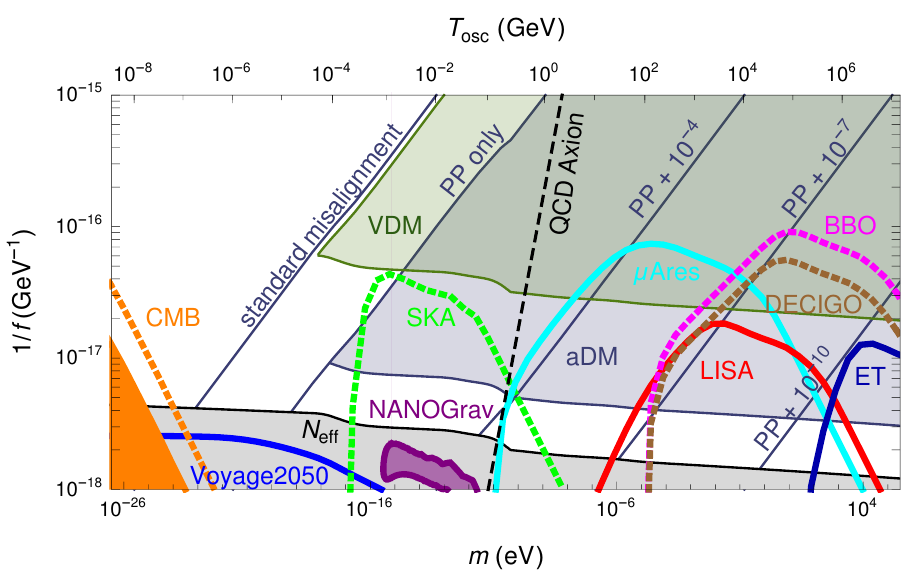
Figure 8: ALP parameter space in the mass vs. inverse decay constant plane with α = 100 and θ = 1 held fixed. The parameter space below the bright colored curves could be probed by future GW experiments, such as pulsar timing arrays (SKA) as well as space- (LISA, DECIGO, BBO, µ Ares) and Earth-based (ET) interferometers. The filled orange region corresponds to the present limits from Planck + BICEP2 + Keck and the dashed line shows the possible improvement by the LiteBird mission. The blue curve is the limit on CMB spectral distortions that could be probed by the Voyage2050 mission. The purple region is where the model could account for the recently re- ported NANOGrav signal. The gray region is excluded in case of a relativistic dark photon by bounds on N , while in the green region a massive dark photon can be eff a viable DM candidate. The solid diagonal lines refer to axion dark matter scenarios in which, from left to right, there is no particle production (standard misalignment), only the suppression from particle production ≈ 10 − 2 (PP only), or further suppres- sion η from model extensions (PP + η ). In the blue shaded area, the axion is cool enough to be DM, assuming sufficient suppression of the relic